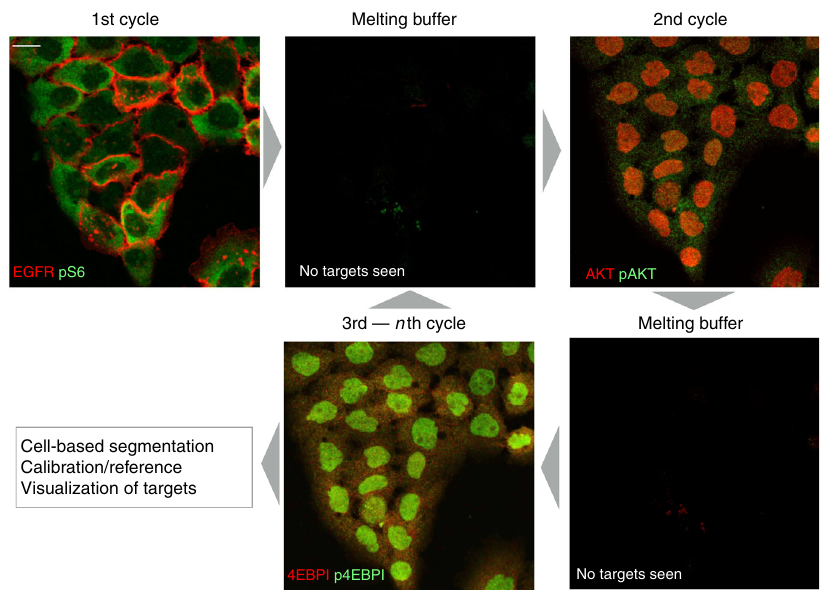
Fig. 2 Serial imaging of multiple targets within the same cell. mAb – DNA conjugates against EGFR and pS6 were used for the fi rst round of staining in cultured A431 cells (pseudocolored with red and green, respectively). Note the expected location of each protein. Within minutes of addition of the melting buffer (deionized water), the targets are no longer detectable by imaging. In the second cycle, mAb – DNA conjugates against AKT and pAKT were imaged (again, pseudocolored with red and green). The second round of melting buffer was used to dissociate the imaging strands. During the third cycle of imaging, 4EBPI (red) and p4EBPI (green) were imaged in the same cells. The cycles can then be repeated until all desired markers have been analyzed. Scale bar (top left) represents 20 µ